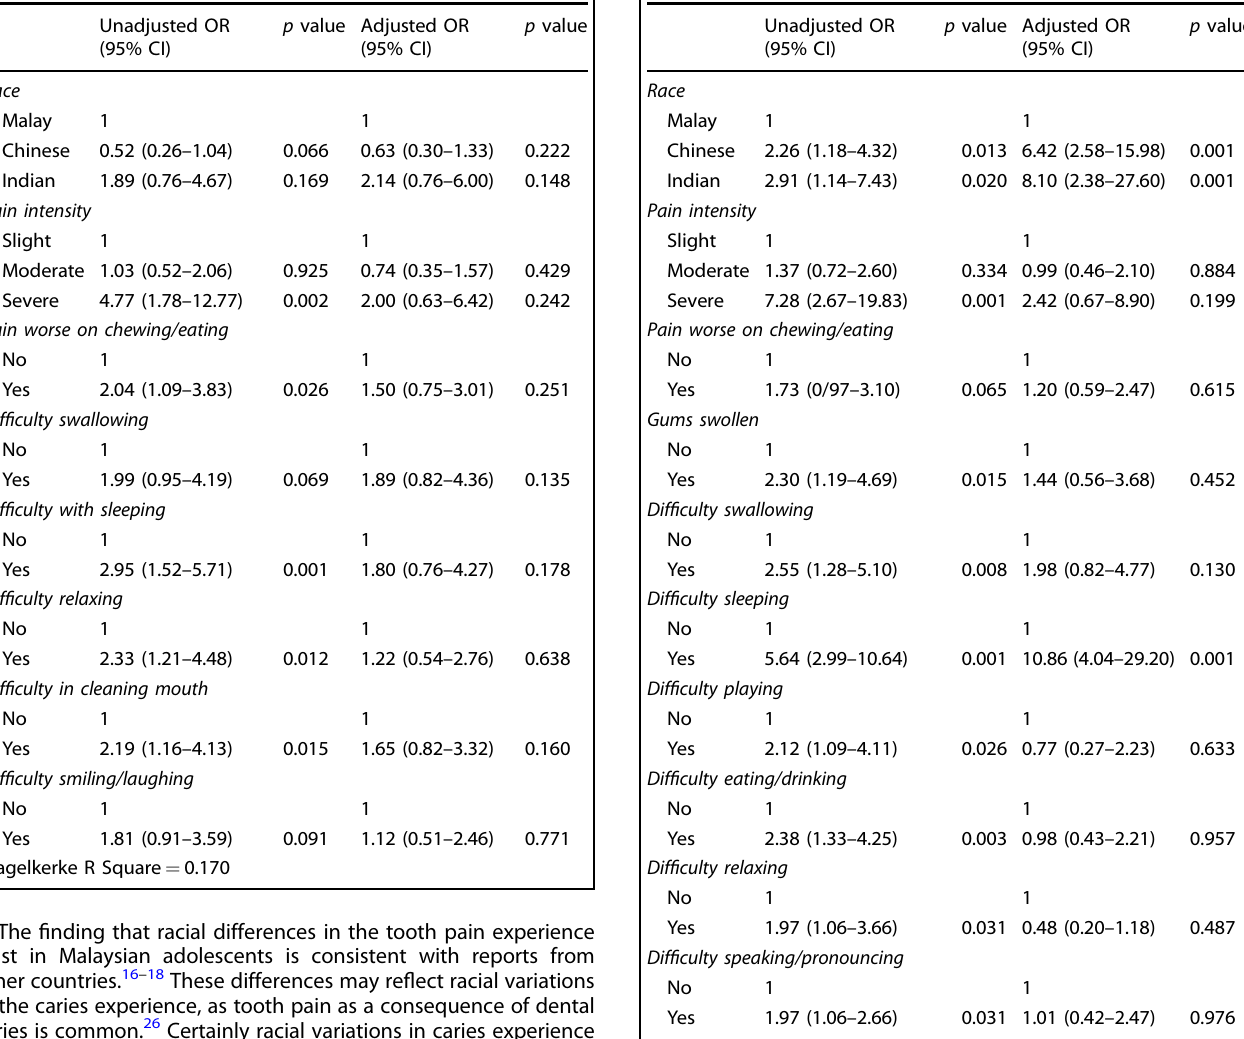
Table 5. Unadjusted and Adjusted Odds Ratios (ORs) with 95% Con fi dence Intervals (95% CIs) for the association between medication use for tooth pain in the past 1 month and race, pain symptoms and social impacts.